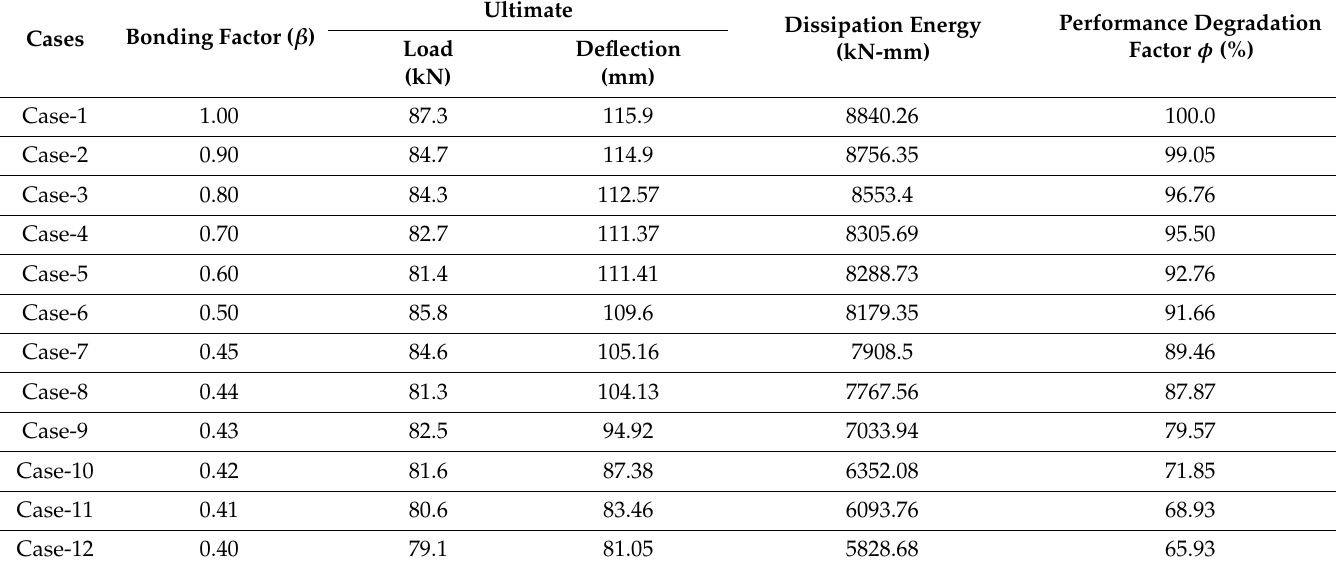
Table 3. Analytical results for each flexural